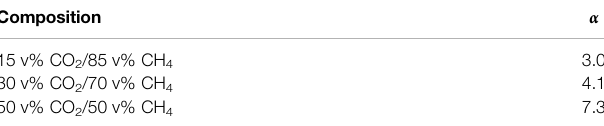
TABLE 1 | Separation factors for different compositions of feed gas.